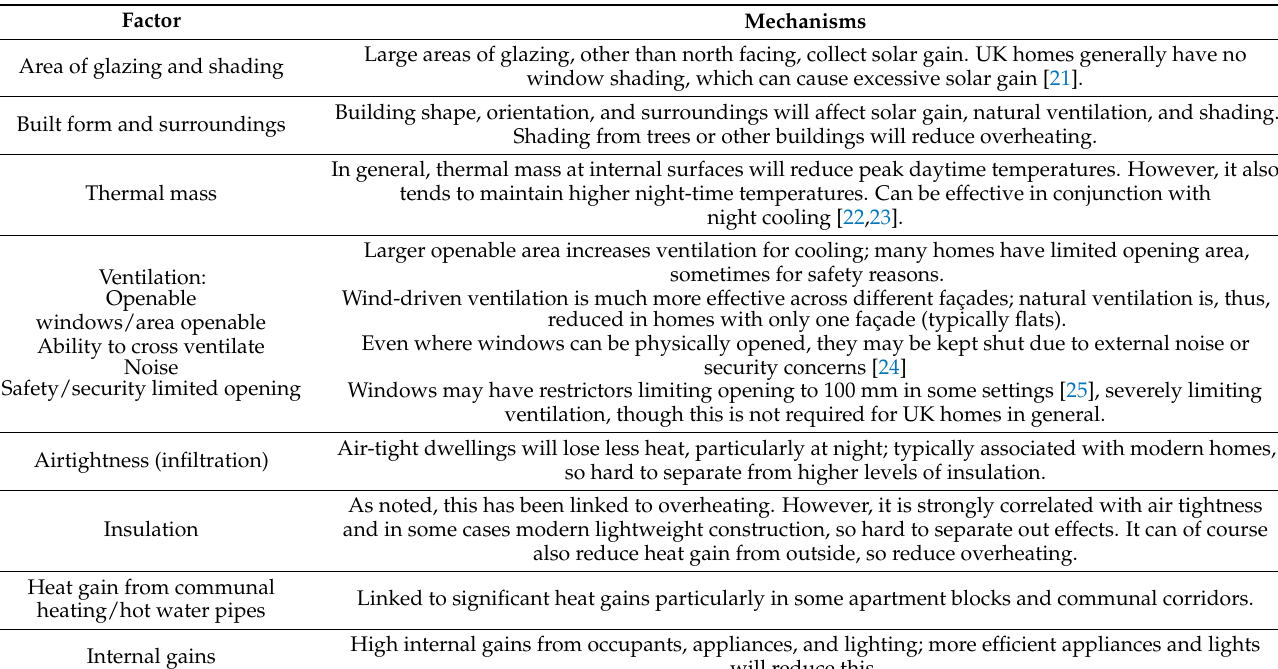
Table 1. Key factors affecting overheating in